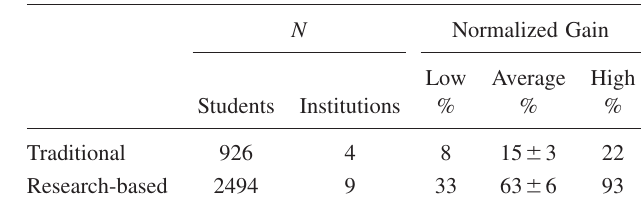
TABLE I. FMCE normalized gain for more than 3000 students at ten colleges and universities divided into two categories: tradi- tional instruction and research-based methods. Three institutions are included in both categories. Uncertainties shown are standard errors in the mean with N equal to the number of